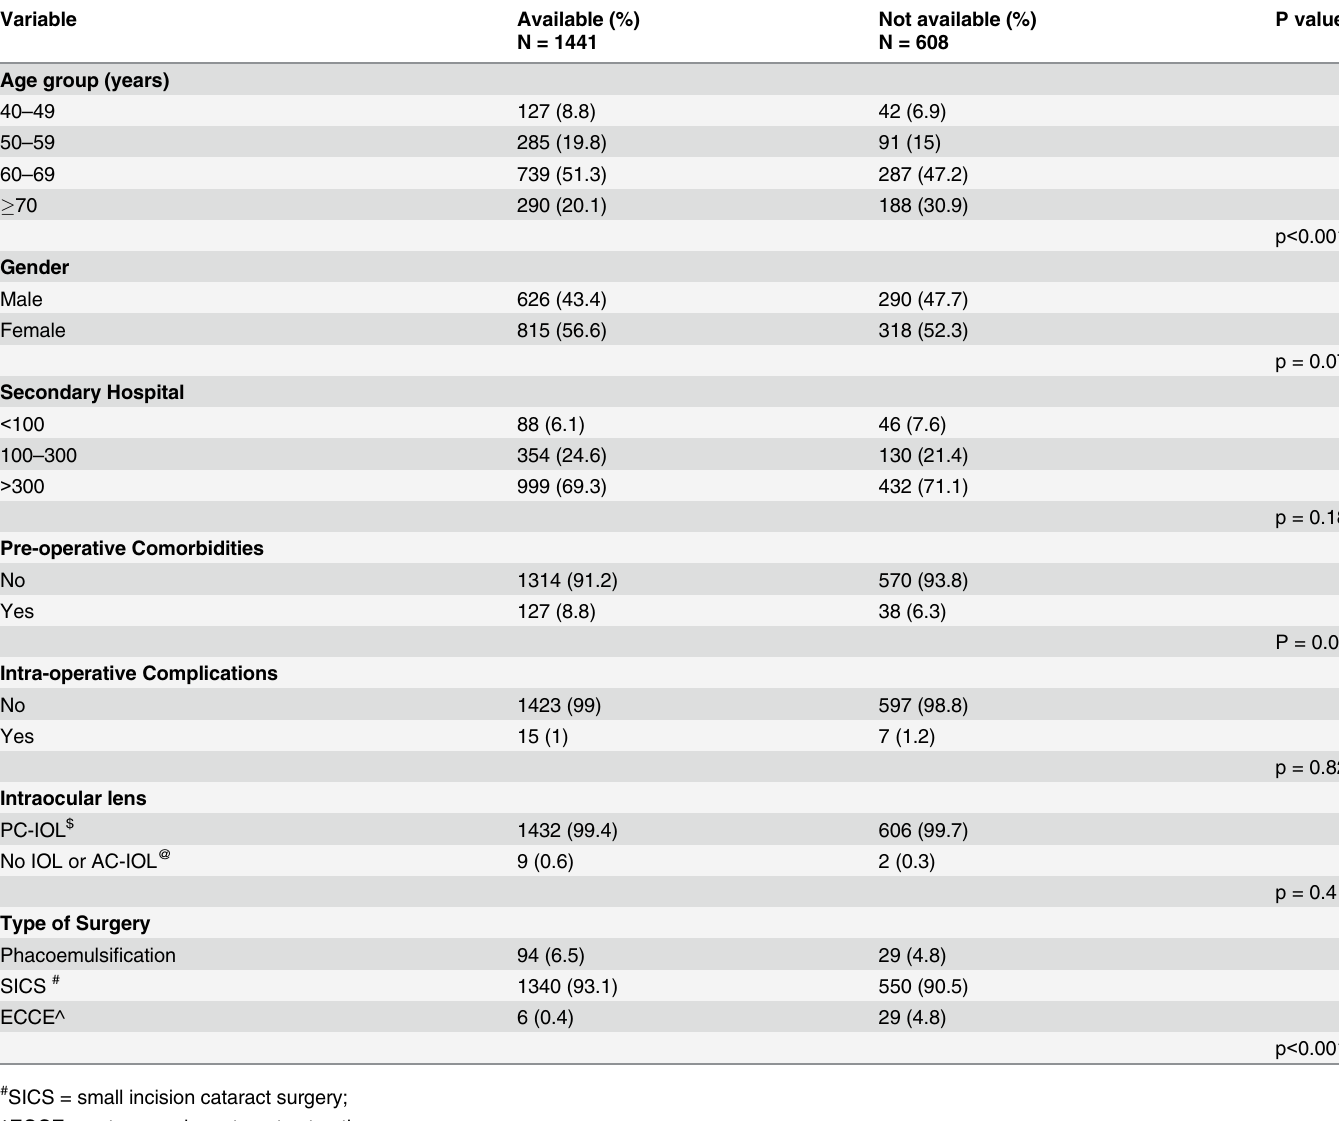
Table 4. Demographic and ocular characteristics of those followed-up versus not followed-up at 4 – 11 Week Follow Up.